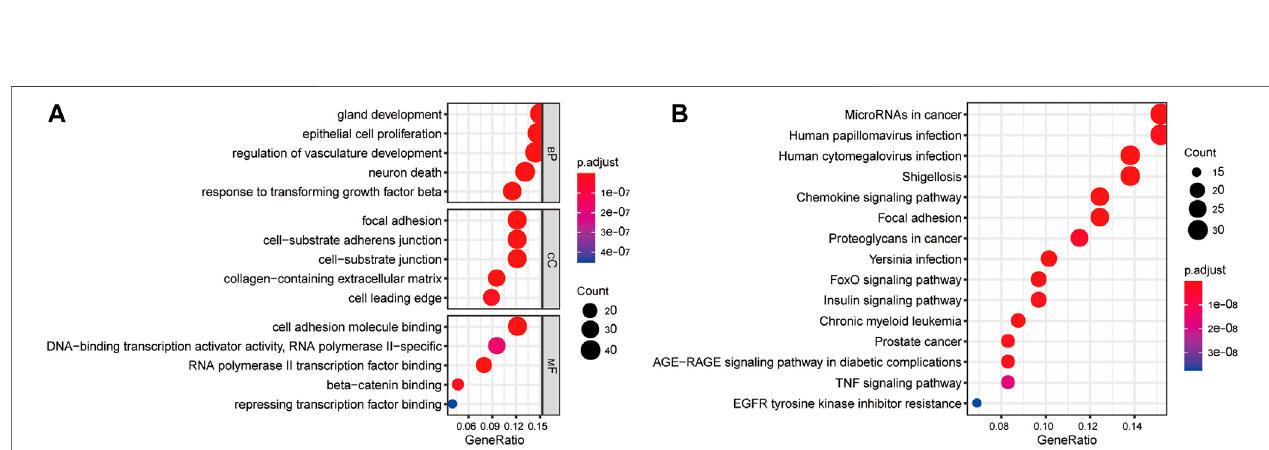
FIGURE 3 | Gene enrichment analysis of differentially expressed EMT-correlated genes. (A) . Enriched GO terms of differentially expressed EMT-correlated genes (Top5). (B) Enriched pathways of differentially expressed EMT-correlated genes (Top15). Notes: EMT, Epithelial-mesenchymal transition; GO, gene ontology; BP, Biological Process; CC, Cellular Component; MF, Molecular